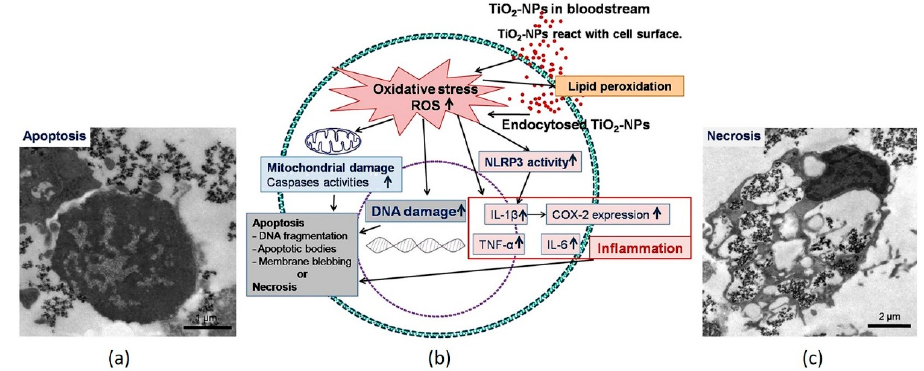
Figure 7. Cytotoxic mechanisms of peripheral blood mononuclear cells (PBMCs) investigated with TiO 2 NPs ( b ). TEM images of apoptosis ( a ) and necrosis ( c ) of PBMCs. (COX-2 = cyclooxygenase-2; IL = interleukin; and TNF = tumor necrosis factor). Adapted with permission from [10]. Copyright, 2016 John Wiley & Sons, Inc.